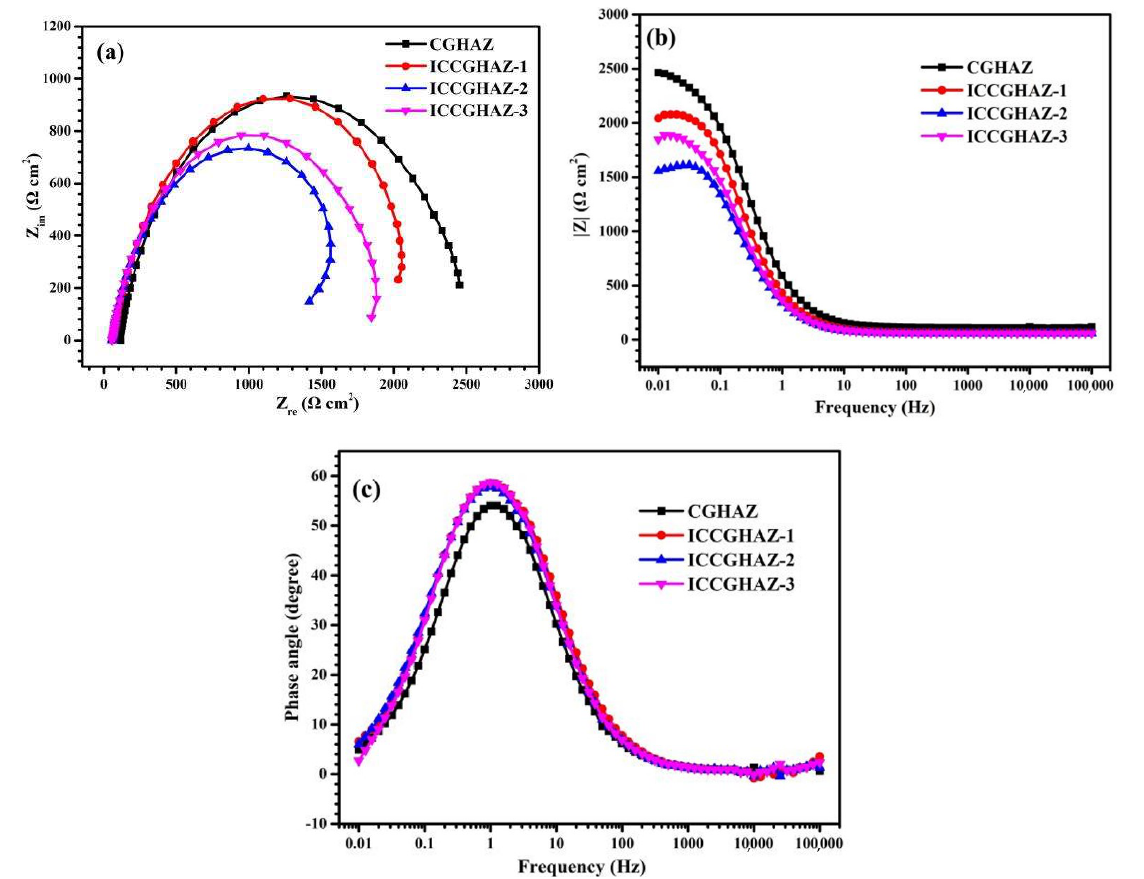
Figure 12. EIS results of the CGHAZ and ICCGHAZs with different secondary peak temperatures in 3.5 wt% NaCl solution: ( a ) Nyquist impedance diagrams, Bode diagrams of ( b ) impedance magnitude vs. frequency and ( c ) phase angle vs. frequency.